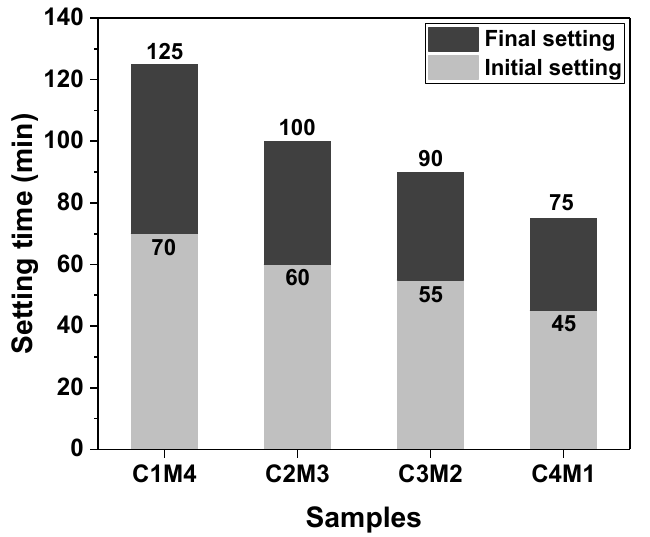
Figure 3. Initial and final setting times of the Na 2 CO 3 -activated slag pastes modified with Ca(OH) 2 and Mg(OH) 2 .